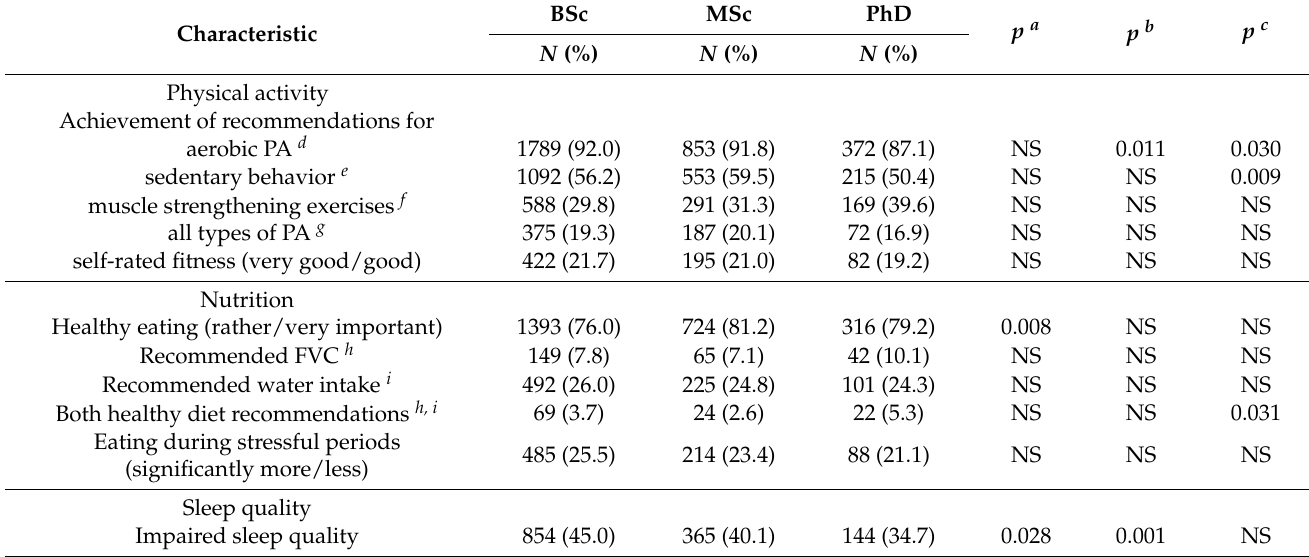
Table 6. Student health behavior and lifestyle characteristics by level of academic